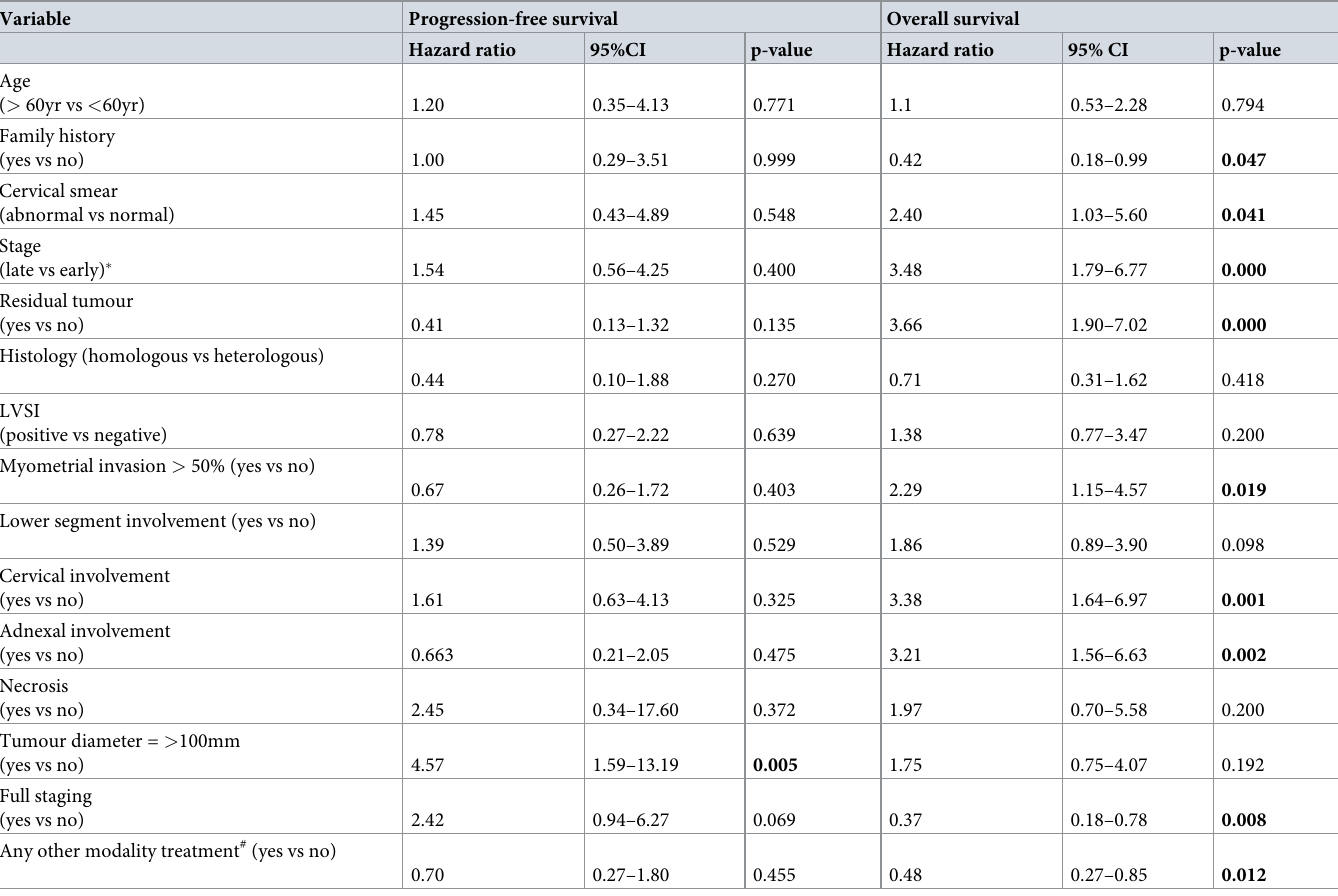
Table 6. Univariate analysis of PFS and OS in patients with uterine carcinosarcoma (significant p-values in bold).